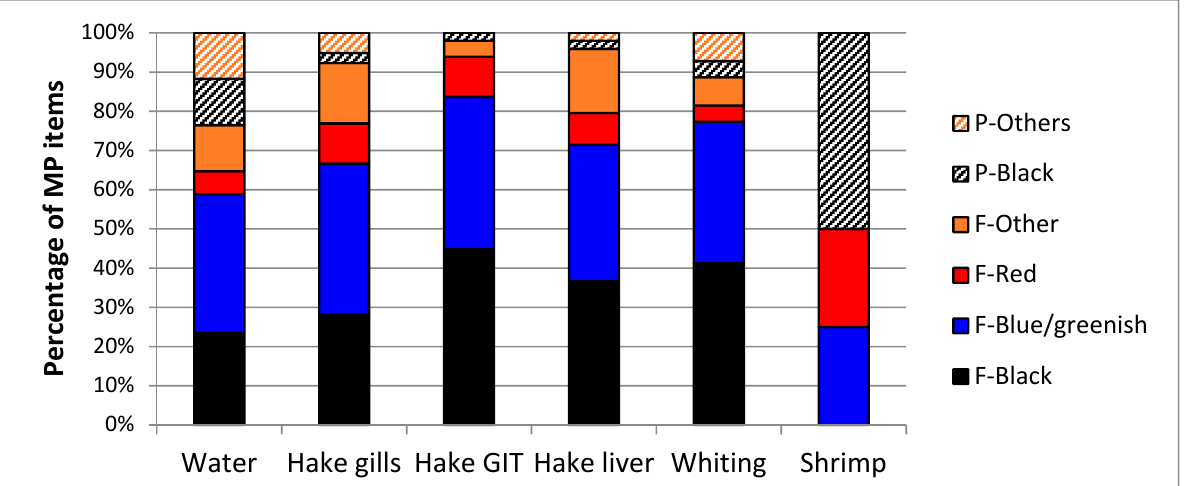
Figure 4 . Types of microplastics in water, hake organs and prey. Items are classified as fibres (= F) or fragments (= pieces, P), by colour.